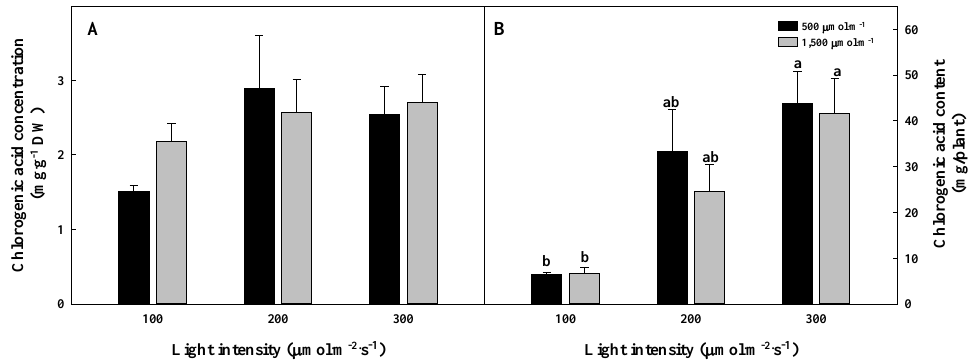
Figure 6. The different chlorogenic acid concentrations ( A ) and contents per biomass ( B ) of Glehnia littoralis Fr. Schmidt ex Miquel shoots, as affected by various CO 2 concentrations and light intensities after 56 days of treatment. The vertical bars represent the standard deviation of the mean ( n = 3). Different letters above bars indicate significant differences at p ≤ 0.05, using Tukey’s multiple range test.